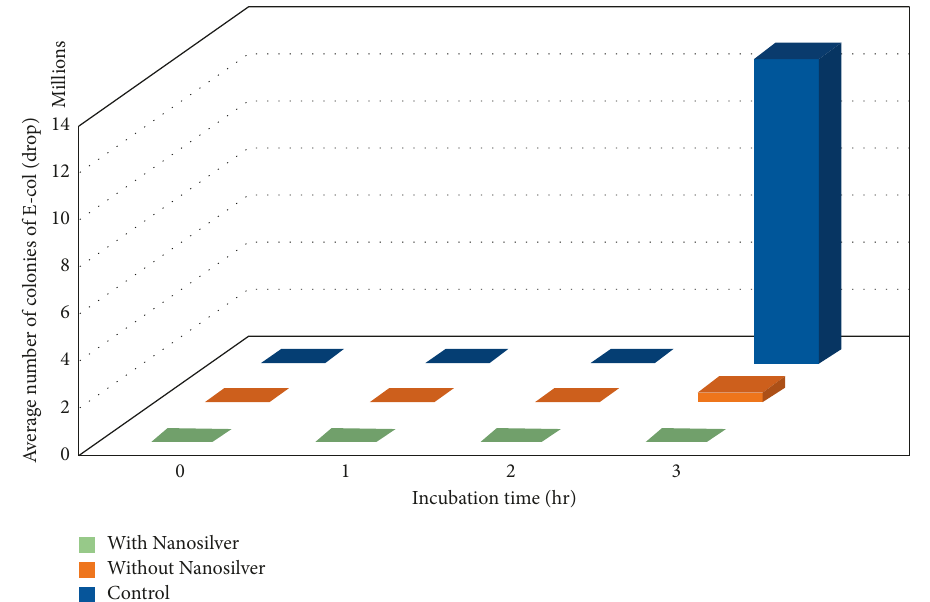
Figure 9: Effect of bacterial growth on the nanofiber with and without AgNPs (reproduced from ref. [55]). Table 1: Shortcomings in traditional face masks and their solutions in nanofabrication. Shortcomings in traditional masks